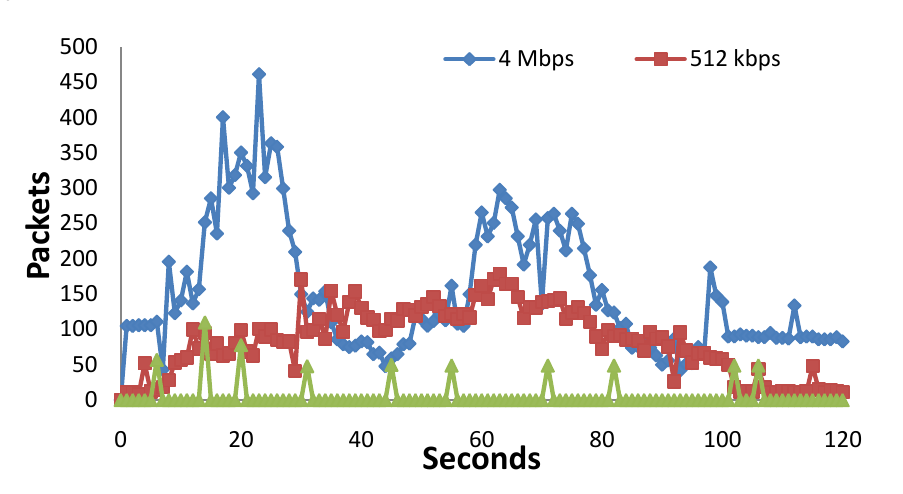
Figure 19. Packets comparison when there is 4 Mbps video stream, 512 kbps video stream and our